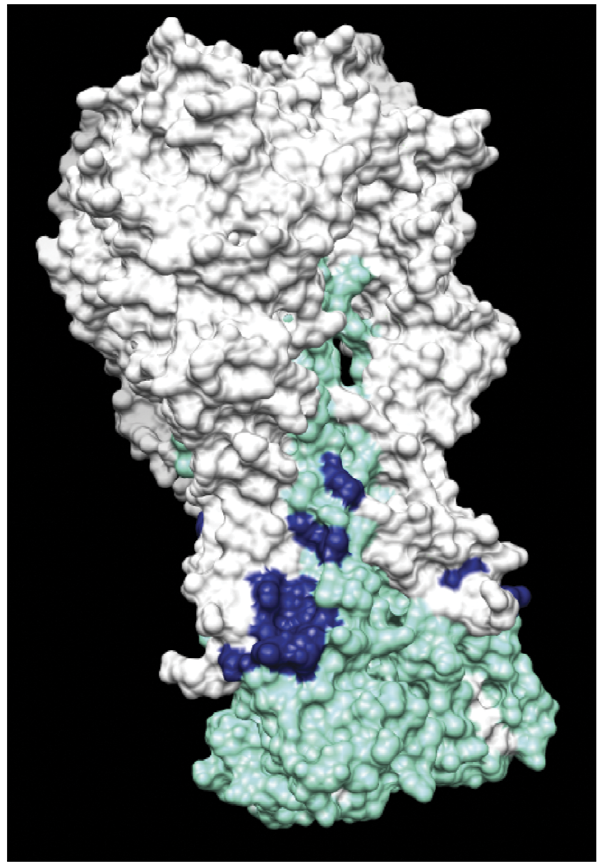
Figure 3. Position of the residues on the surface of (H1N1) A/ PR/8/34 influenza hemagglutinin trimer decreasing the bind- ing of PN-SIA28. White areas indicate the HA1 domains of the HA trimer, whereas cyan areas indicate the HA2 domains. Blue regions depict the mutated residues inhibiting PN-SIA28 binding to HA according to Figure